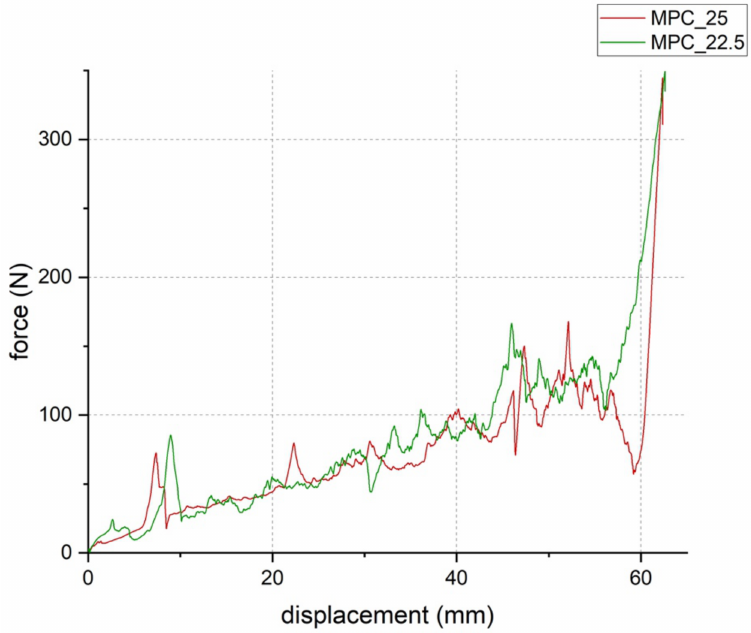
Figure 8. Load-to-displacement curve of MPC_22.5 (green) and MPC_25 (red) throughout the injectability test where force was applied through the traverse of the materials testing machine on the handle of the cement-filled syringe. The peak at the end of the test occurred when the cement was fully pressed out and the handle hit the outlet of the empty syringe (test set-up illustrated in Figure